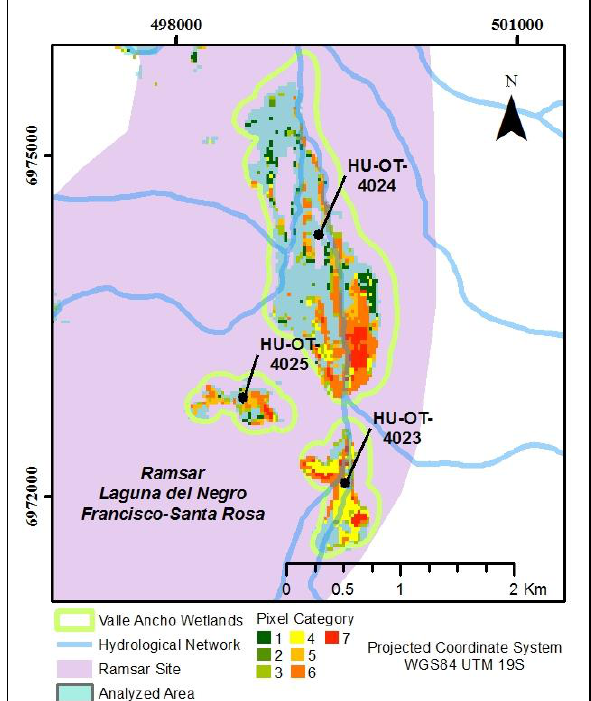
Figure 2. Change detection analysis results for Valle Ancho